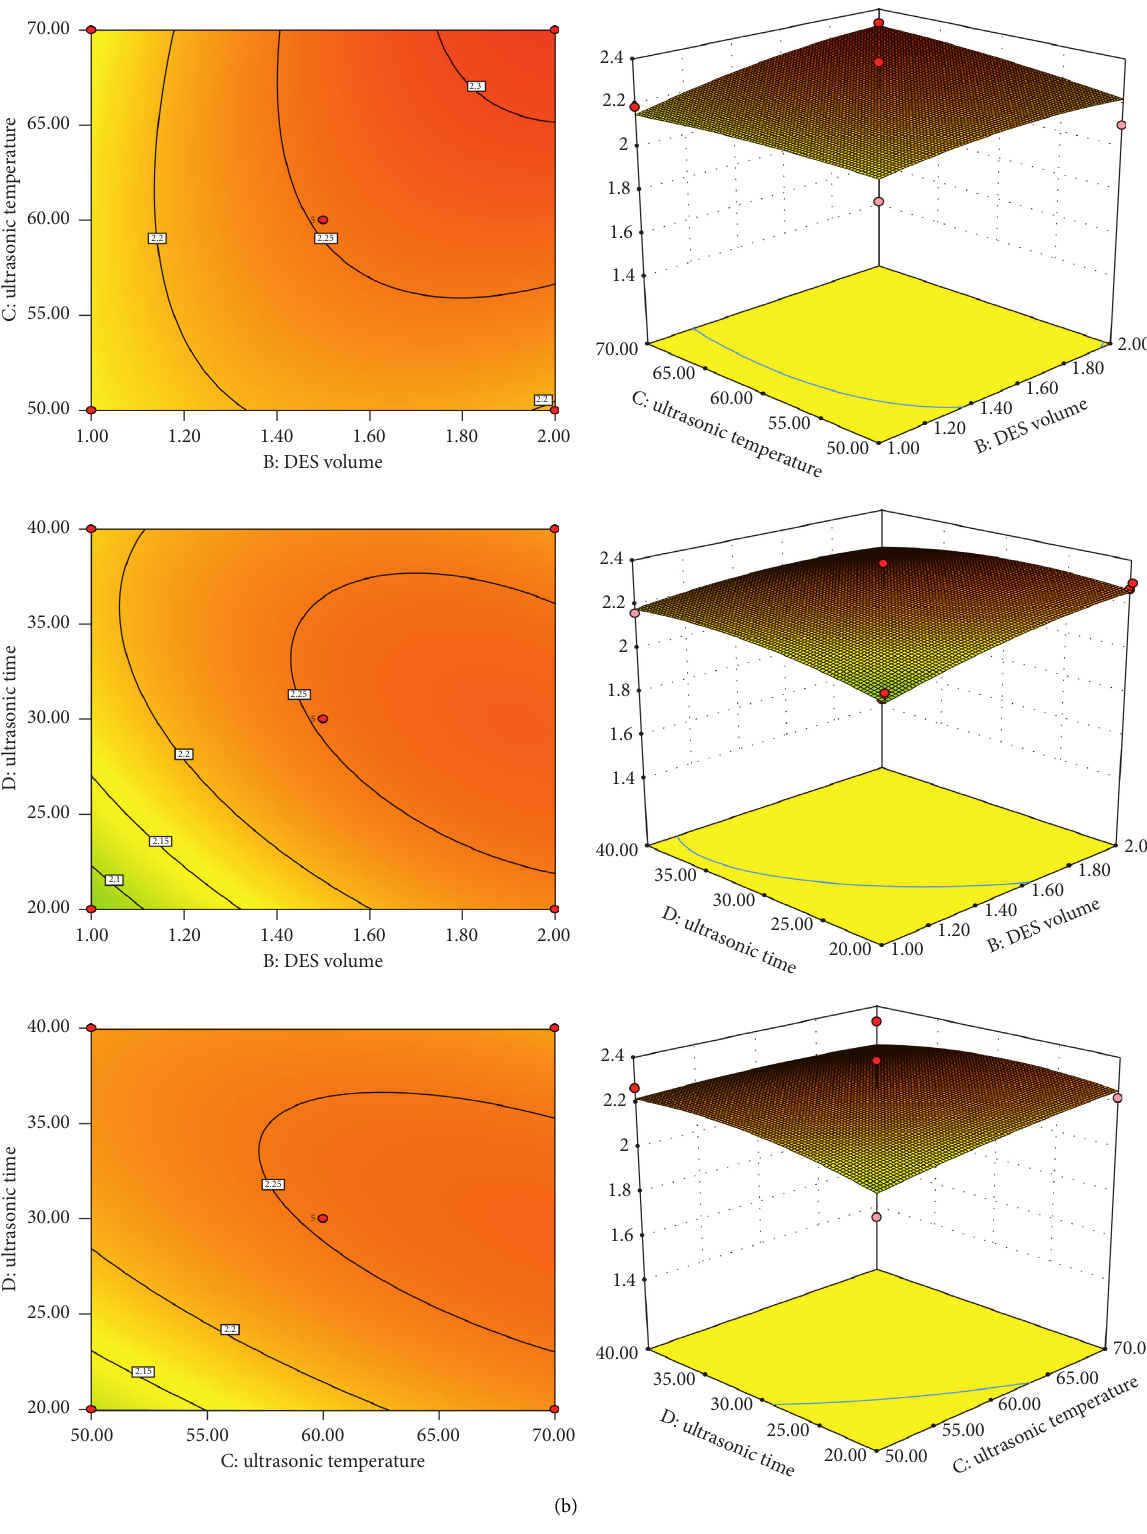
Figure 9: Response surface drawings of CI value analyzed by interaction of two